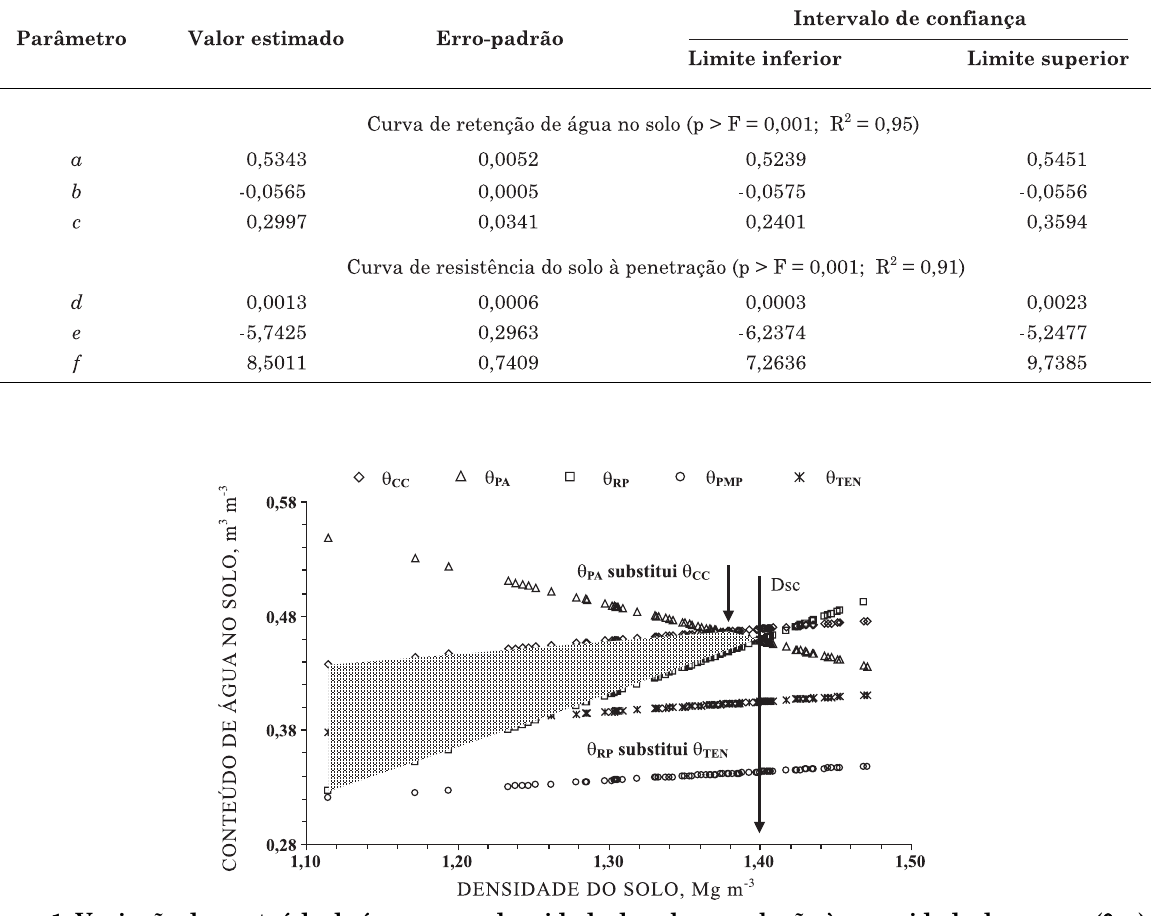
), ao ponto de murcha permanente RP